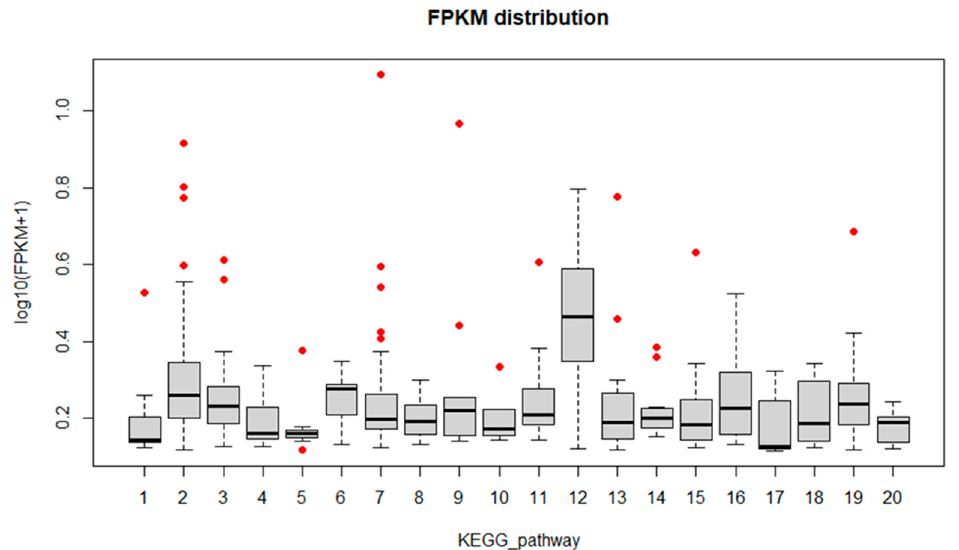
Figure 7. FPKM distribution of the twenty most enriched KEGG pathways. The x -axis is the enriched pathway, the y -axis is the FPKM value expressed as log 10 (FPKM+1) (FPKM > 0.3). Red dots represent the ”outlier” clusters. 1: glycolysis; 2: oxidative phosphorylation; 3: purine metabolism; 4: